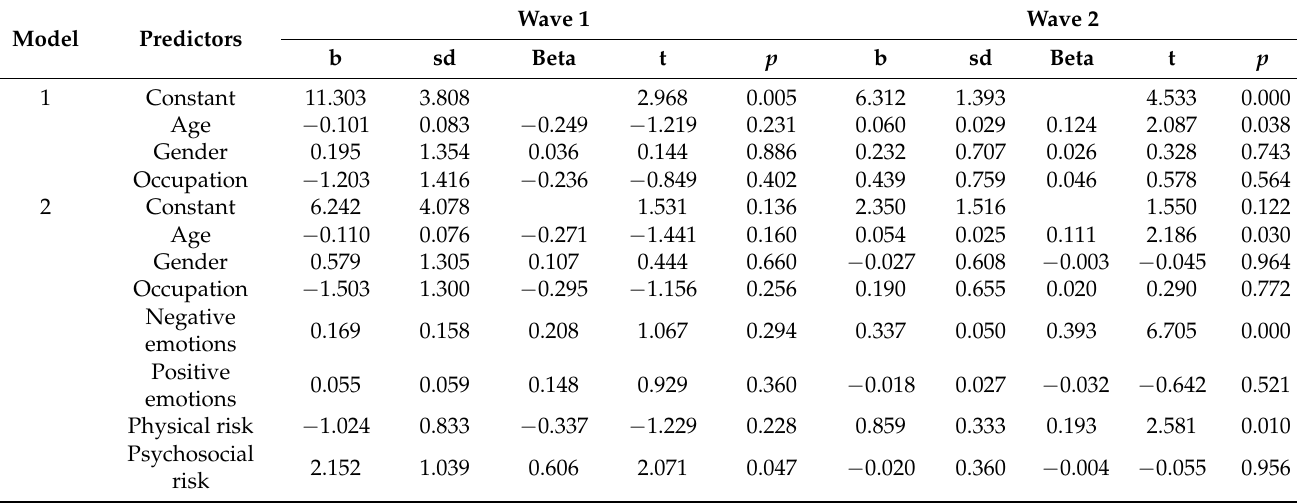
Table 5. Results of the hierarchical multiple regression analysis predicting sleep